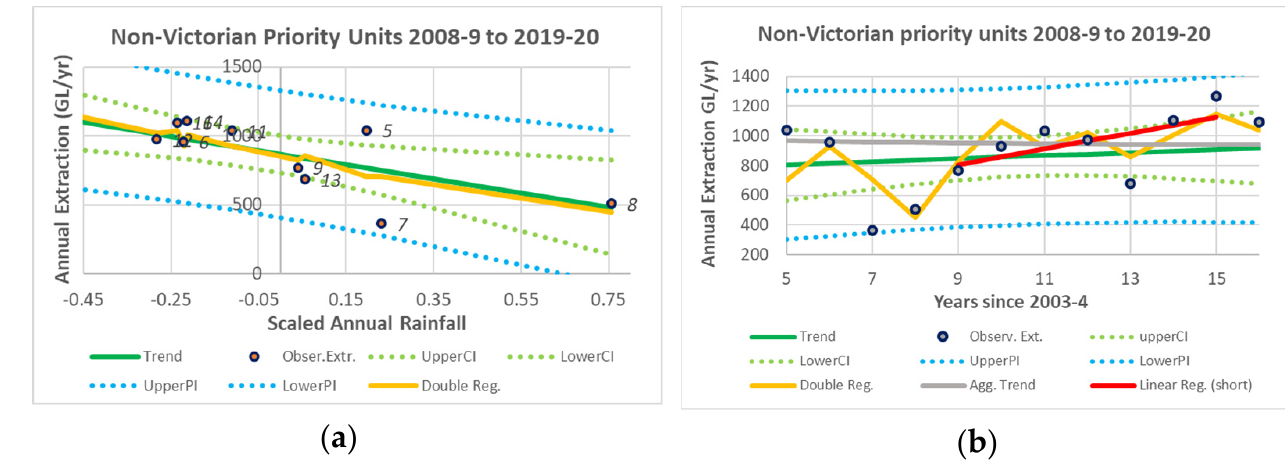
Figure 7. Plots against ( a ) scaled annual rainfall and ( b ) years since 2003–2004 ( a ) represent the years since 2003–2004 of the normalized annual extraction (GL/yr) for the non-Victorian priority units